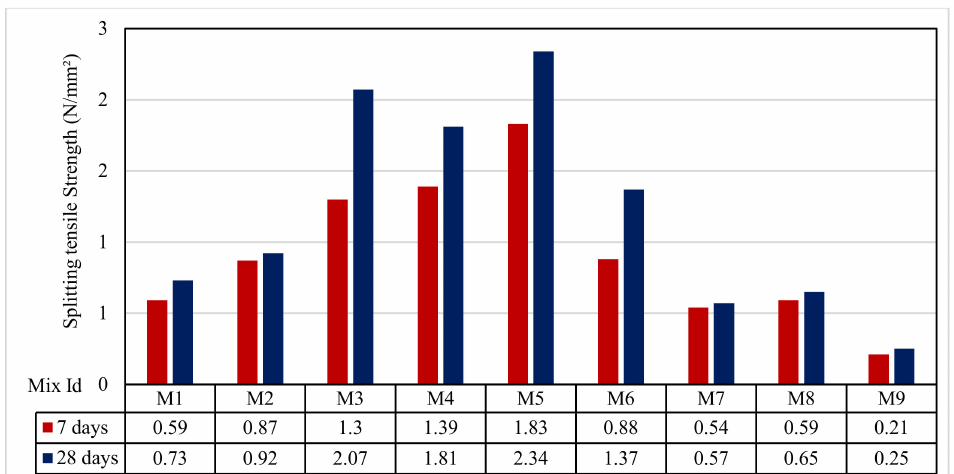
Figure 9. The splitting tensile strength test